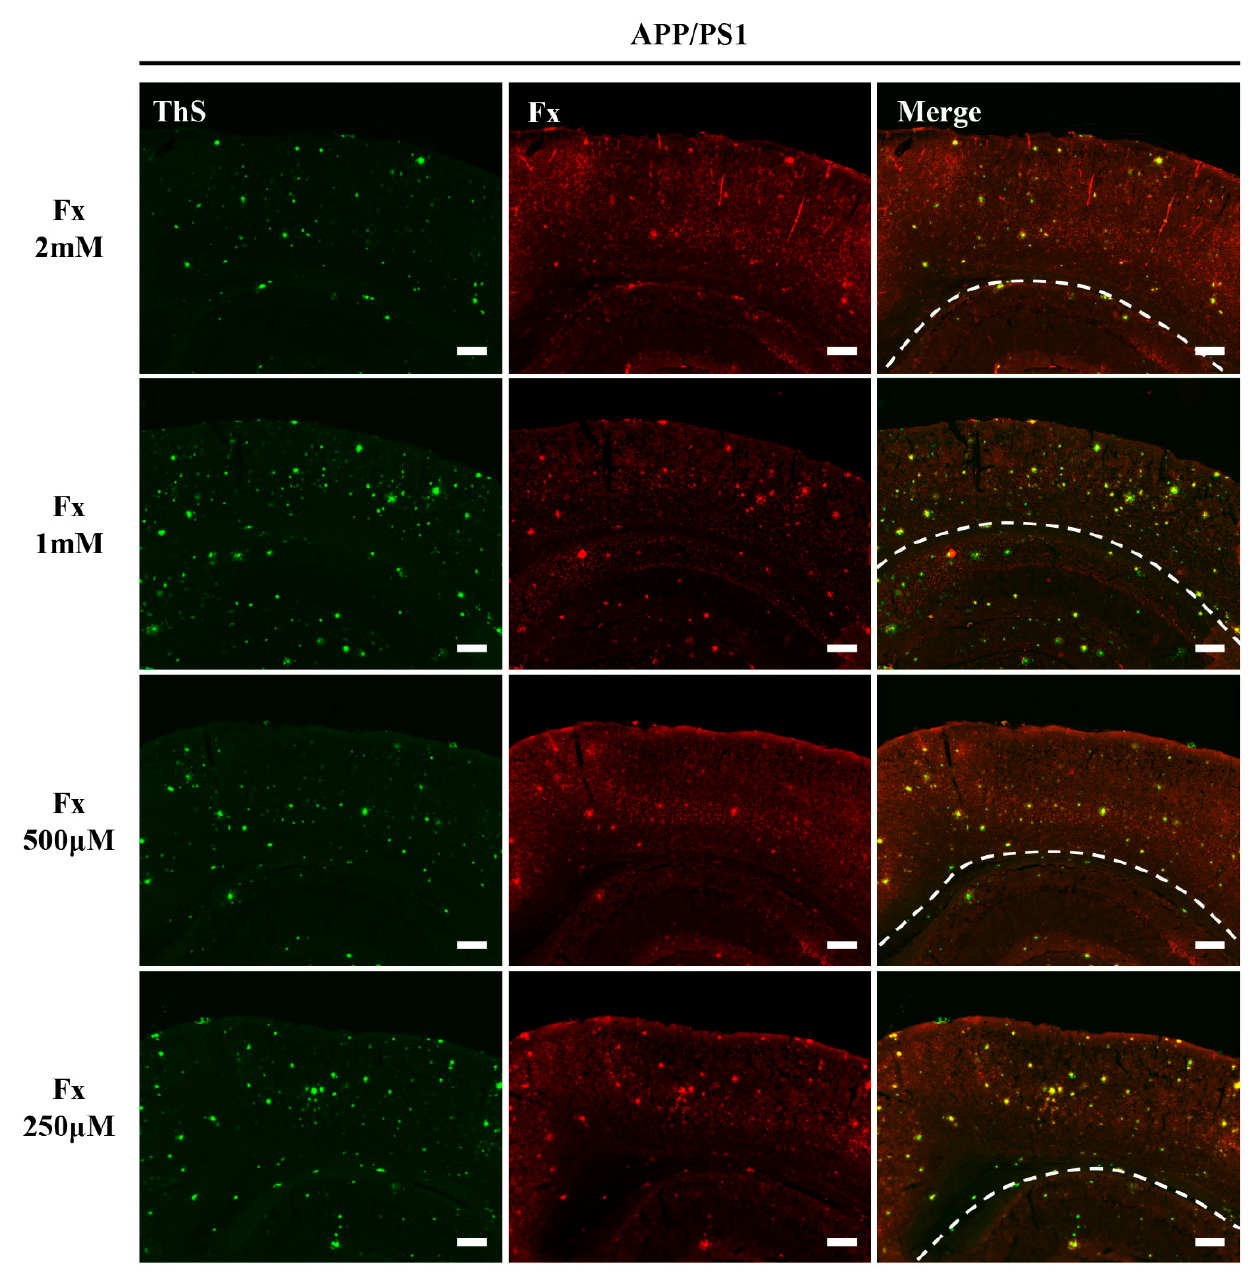
Figure 3. Fucoxanthin staining using the water-based washing method detected ThS-positive A β plaques in APP/PS1 brain tissue. The brains of 10–15-month-old APP/PS1 mice ( n = 4) were visualized for A β plaques with fucoxanthin (Fx) and ThS. The images of ThS and Fx are merged to confirm that they are colocalized. Scale bars = 200 µ m. The region of brain was separated with the white dash line on the images; upper region of dash line, cortex; under region of dash line, hippo- campus.